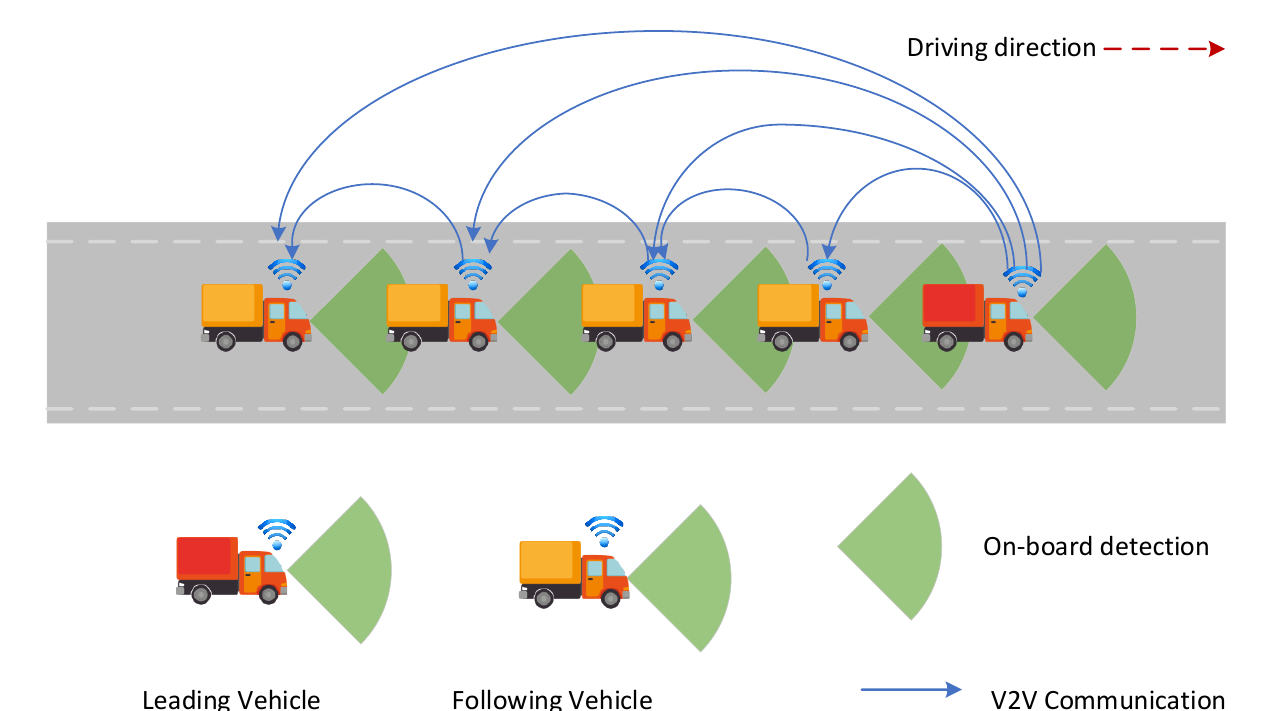
Figure 1. The information flow topology for DIFT without a communication problem.